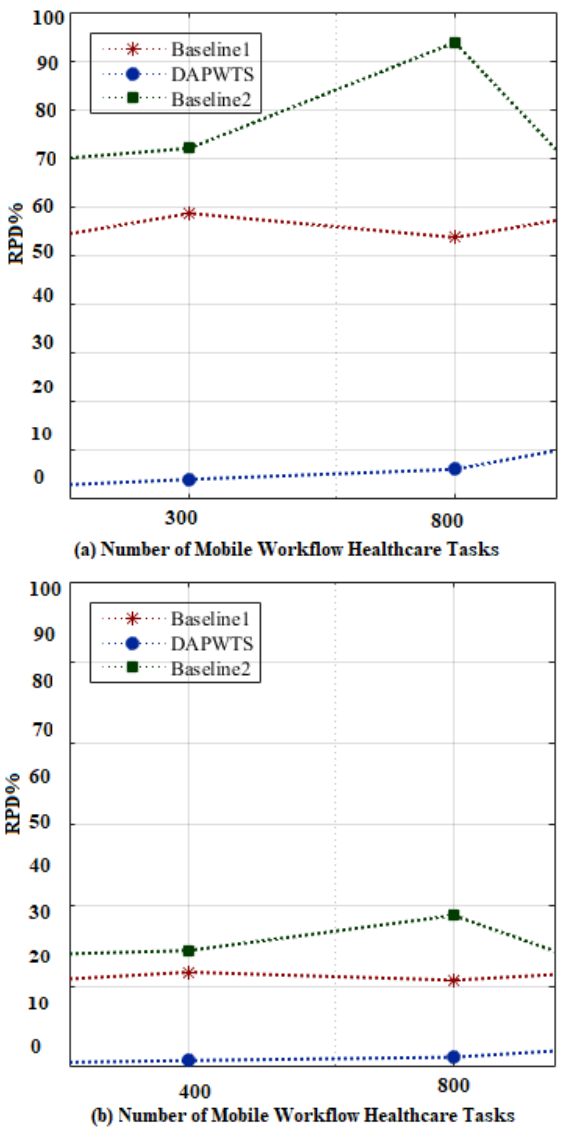
Figure 10. Multiple workflow applications at edge-cloud